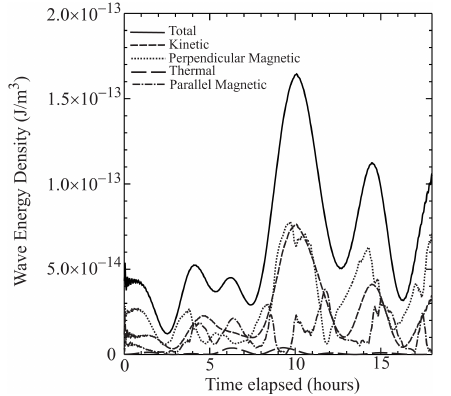
Figure 2. Partition of wave energy density. The wave energy density in the 2.1mHz band is shown by the full curve and the contributions from each field component by the broken curves. Time is measured from 01:31 on 7 June 2000.